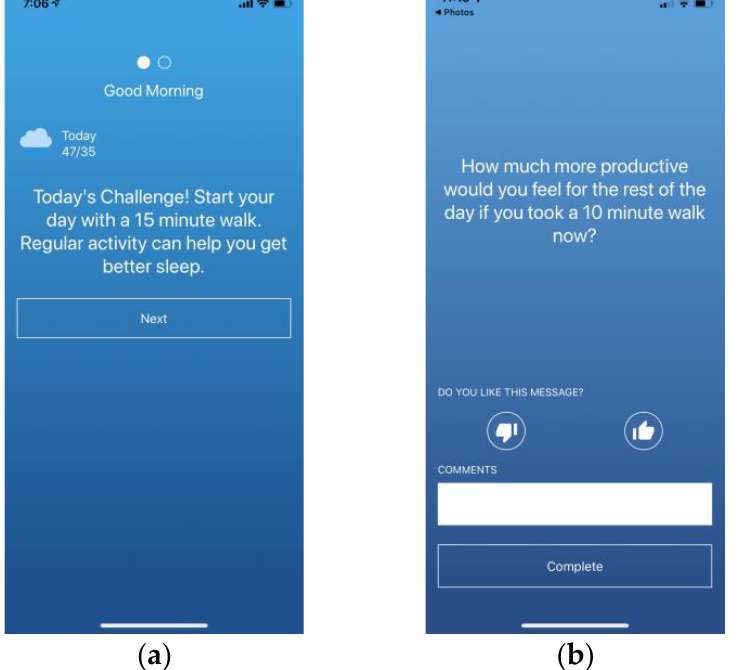
Figure 2. Screenshots of HeartSteps push notifications: ( a ) Morning motivational message; ( b ) walk- ing suggestion.